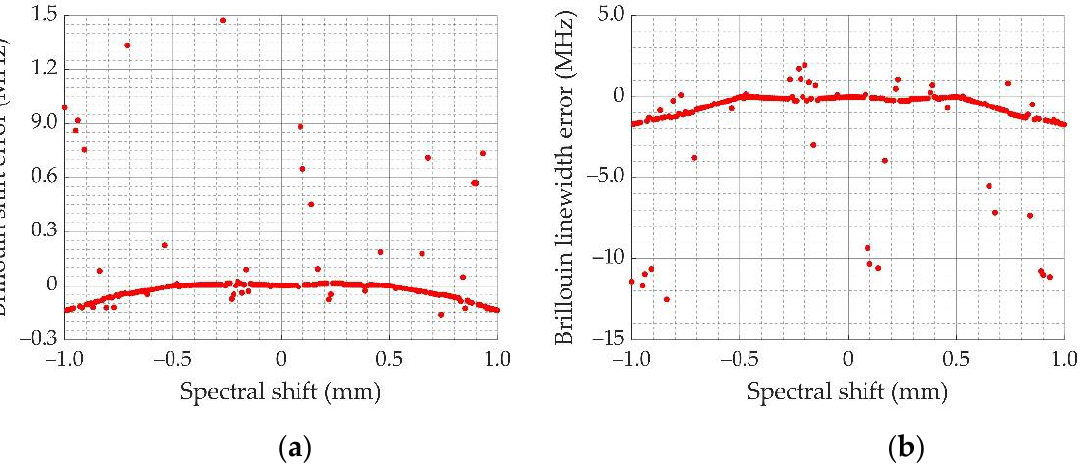
Figure 5. Result of spectral measurement accuracy considering spectral drift: ( a ) Brillouin frequency error retrieved when the spectra shift from -0.762 to 0.762 GHz; ( b ) Brillouin linewidth error retrieved when the spectra shift from -0.762 to 0.762 GHz.